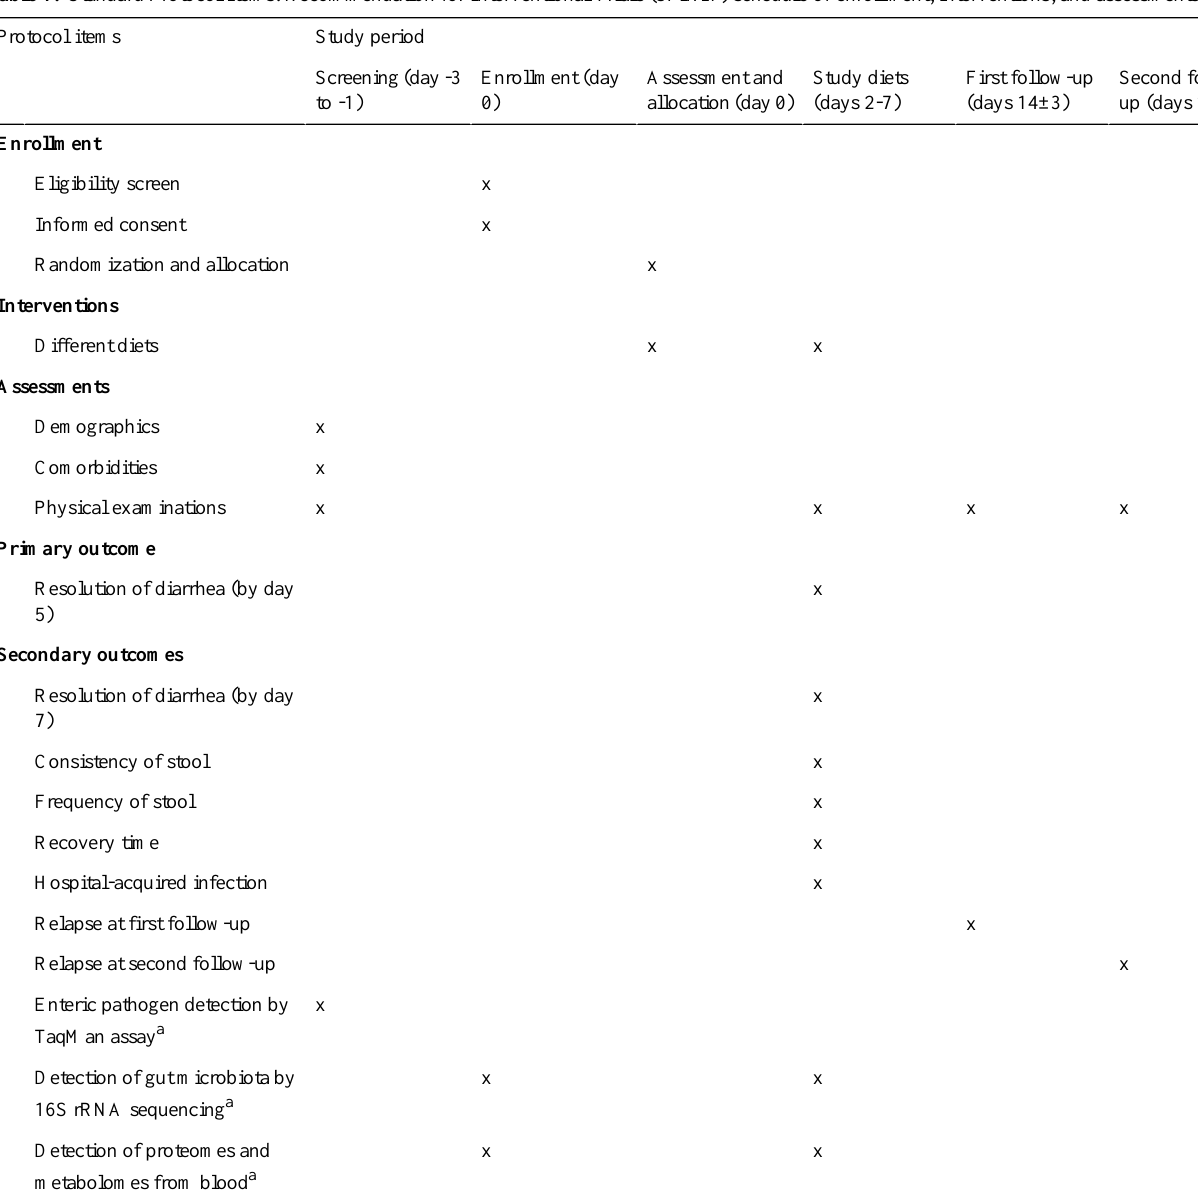
Table 1. Standard Protocol Items: Recommendation for Interventional Trials (SPIRIT) schedule of enrollment, interventions, and assessments. Study periodProtocol items